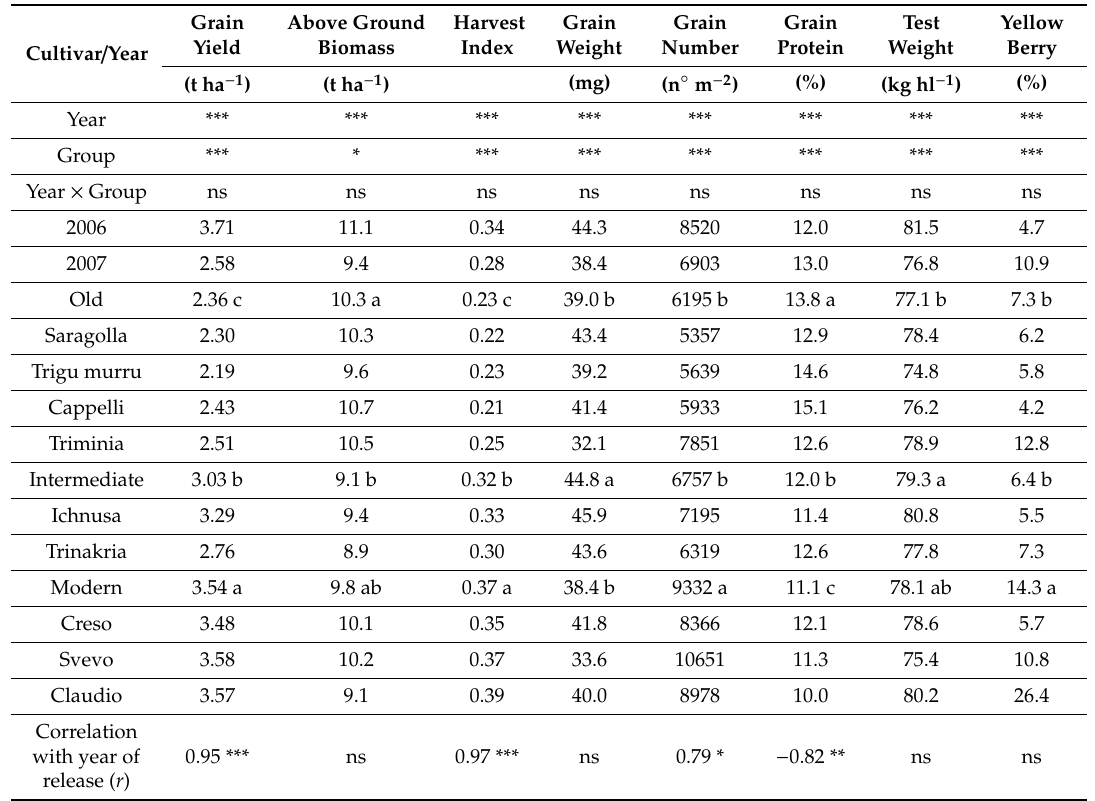
Table 3. Grain yield and grain quality. ANOVA results, means, and coe ffi cient of correlation ( r ) with the year of